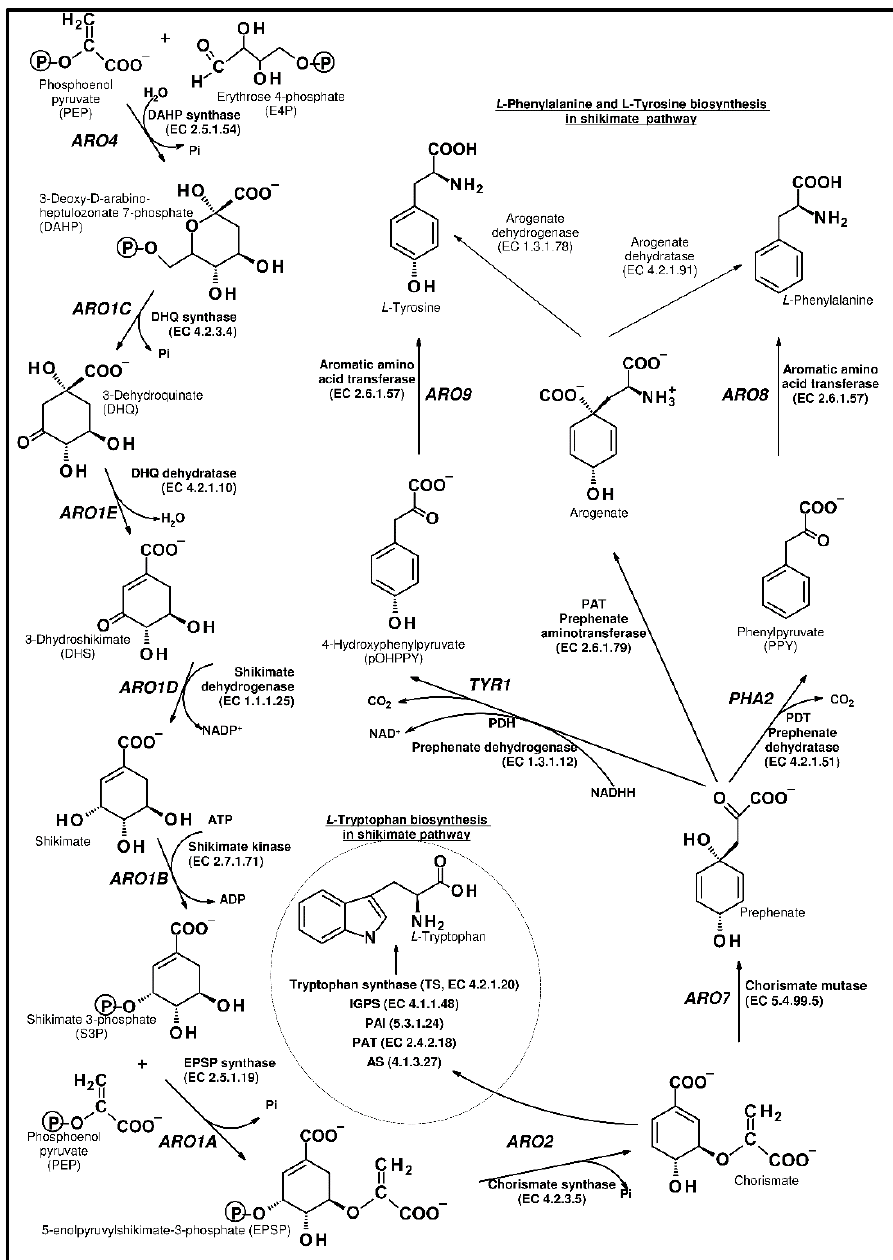
Figure 2. The aromatic amino acid pathway.